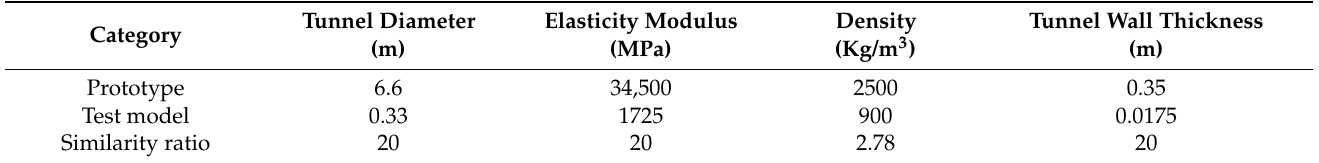
Table 3. Similarity ratio of tunnel test model.